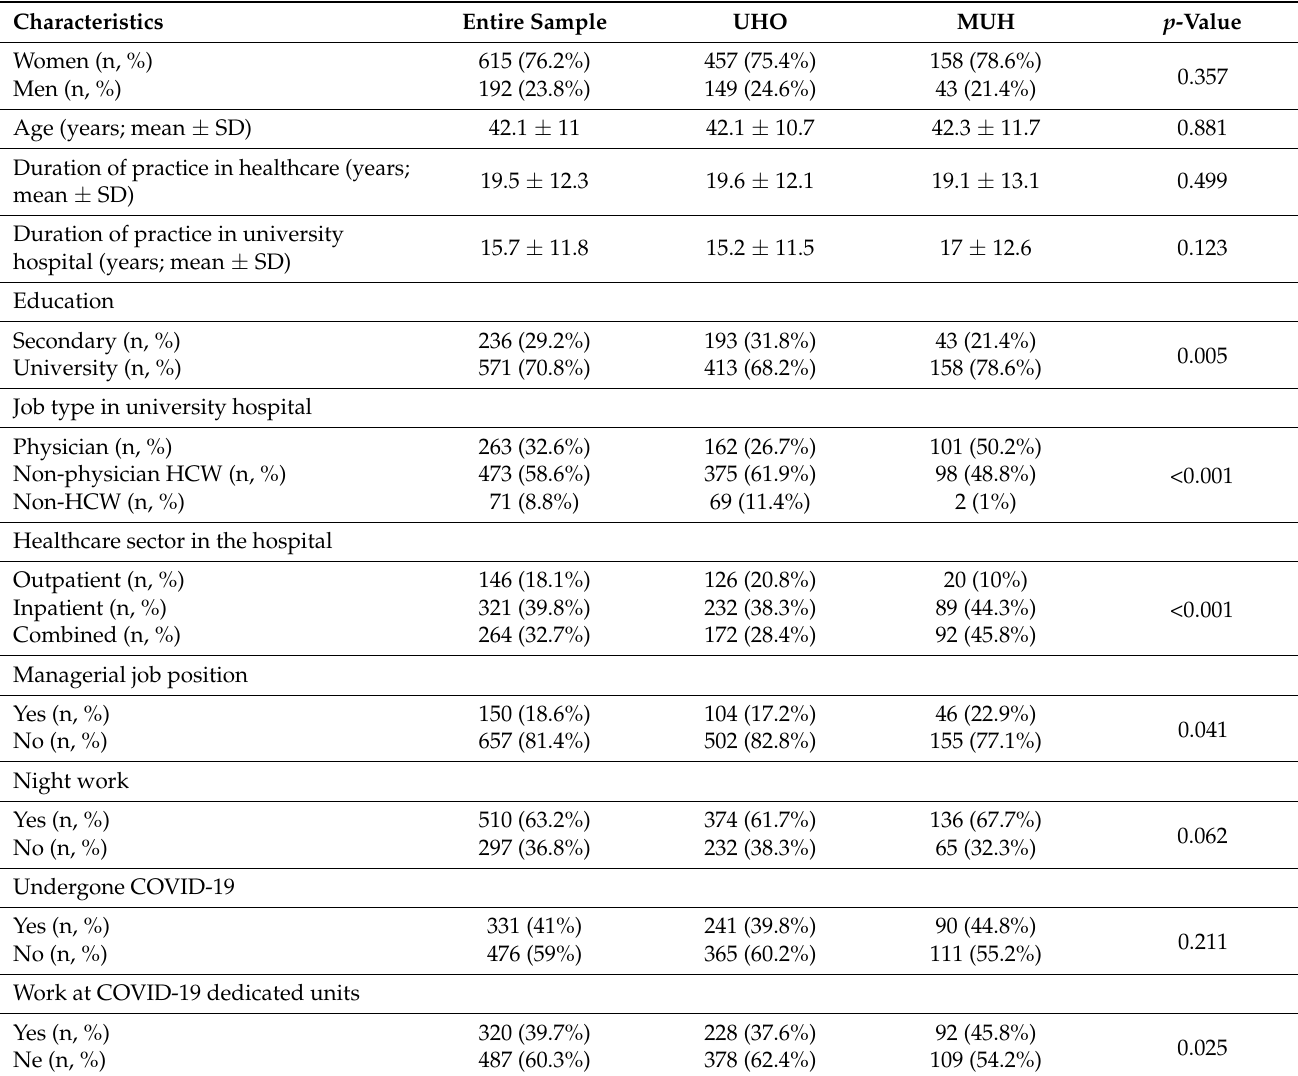
Table 2. Characteristics of the study